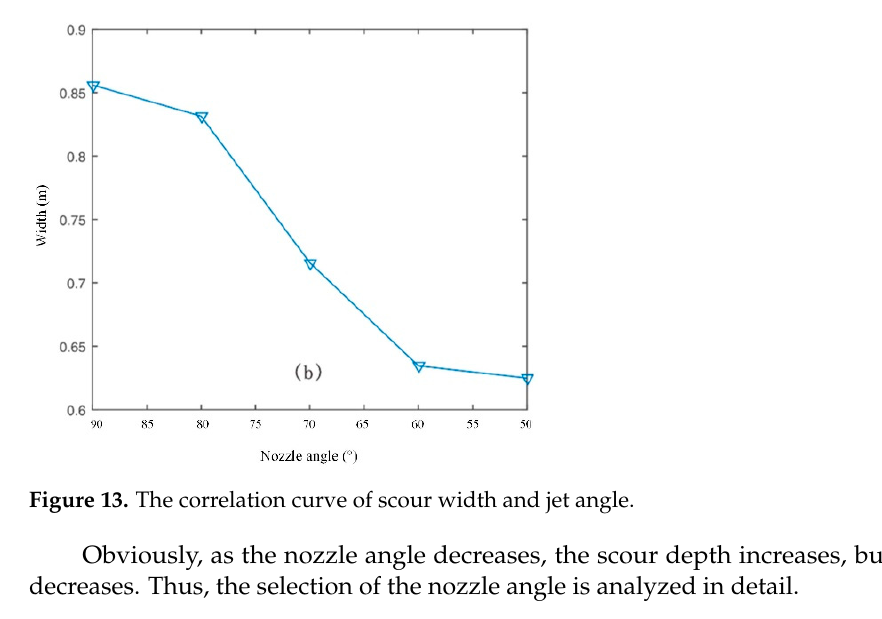
Figure 12. The correlation curve of scour depth and jet angle.